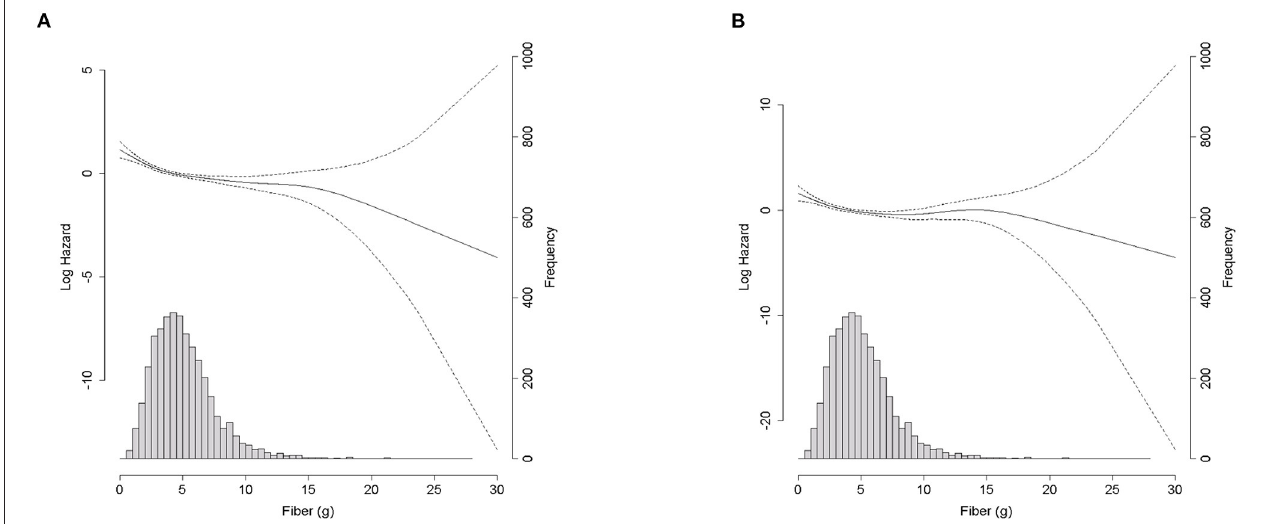
FIGURE 2 | Density plot of fiber intake (g/day) and spline curve for all-cause mortality and CVD mortality according to dietary fiber intake (g/day). (A) All-cause mortality. (B) Cardiovascular motality.